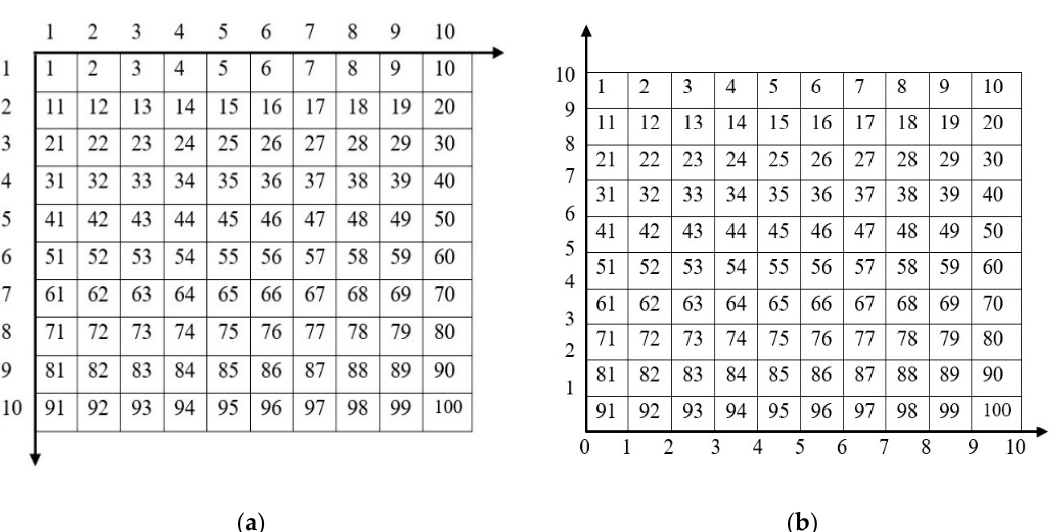
Figure 1. Grid-based Environment. Sensors 2020 , 20 , x FOR PEER REVIEW